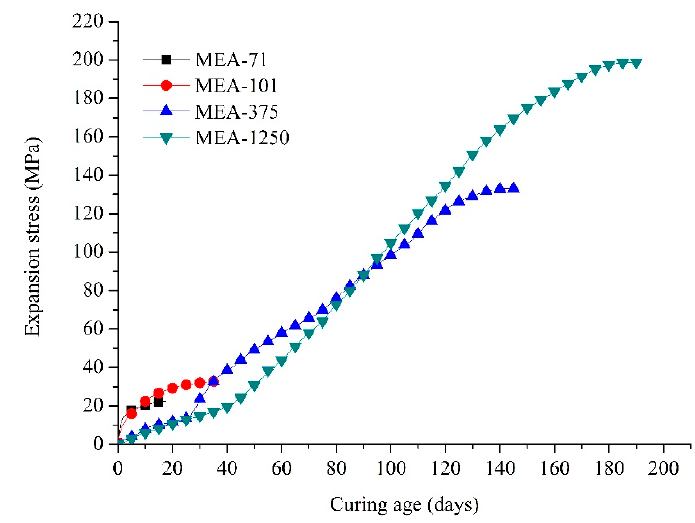
Figure 3. Expansion stress curves of compacted MEA-71, MEA-101, MEA-375 and MEA-1250 cured in water at 40 °C.